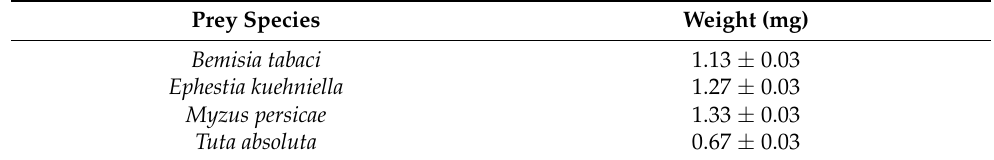
Table 2. Weight (mean ± standard error) of groups of 50 prey individuals ( Bemisia tabaci 4th instar